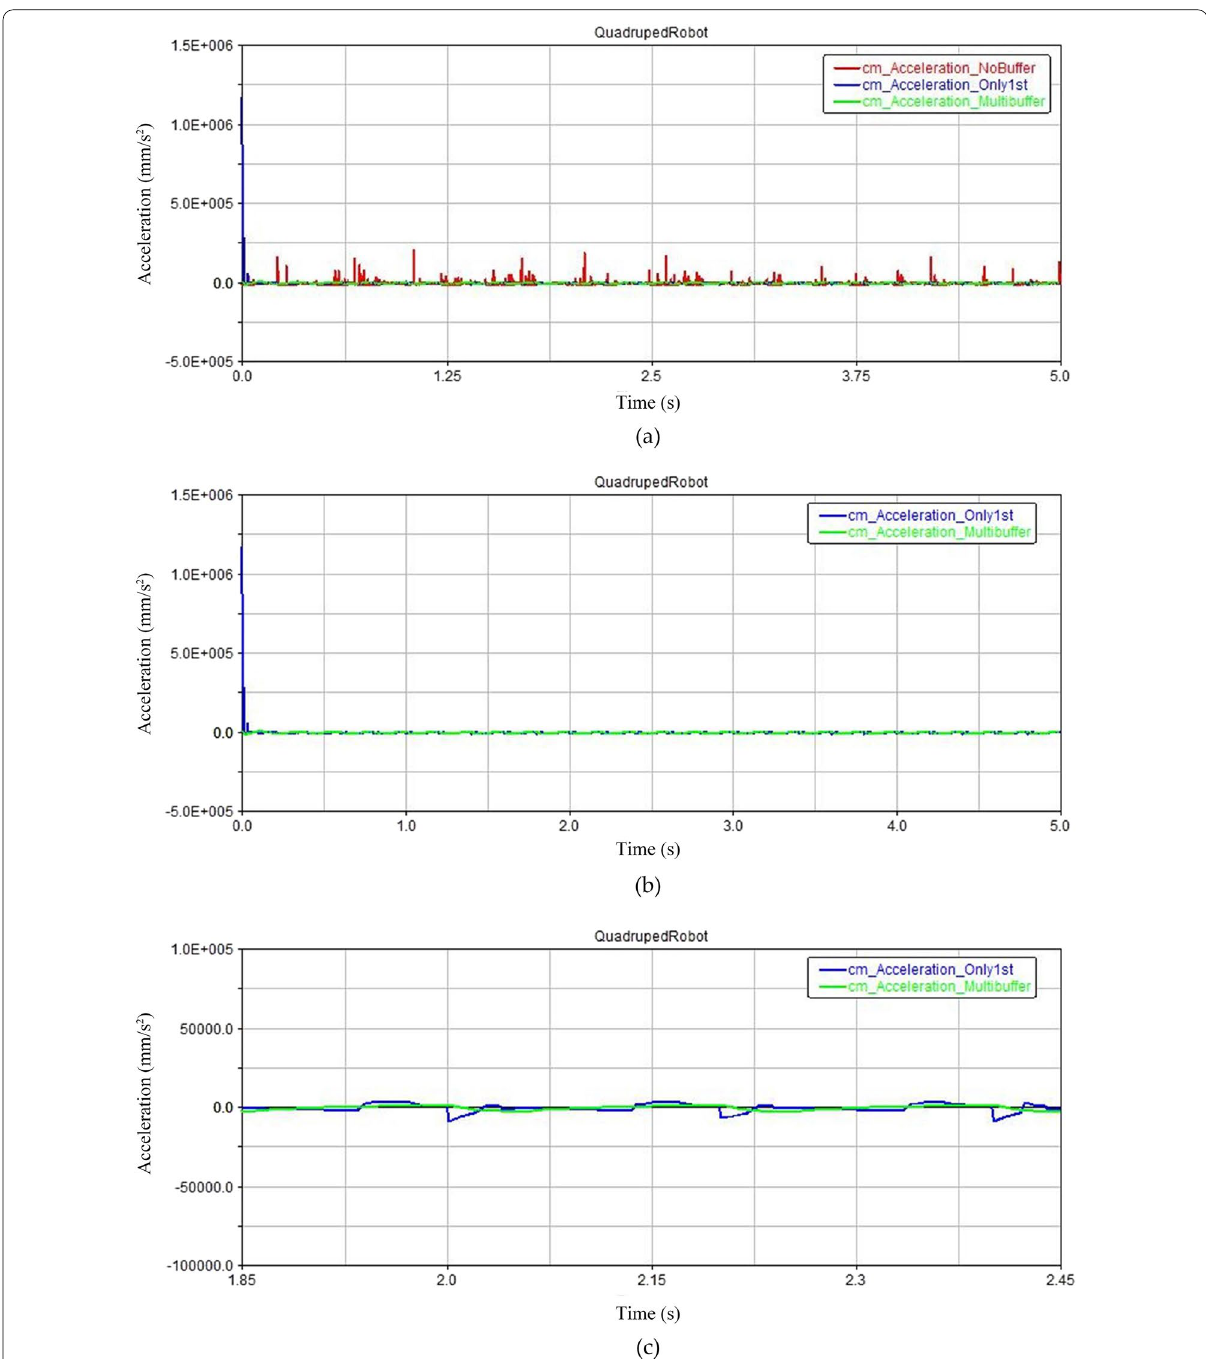
Figure 26 ADAMS simulation results: a acceleration variation of the robot COM in three cases, b acceleration variation comparison between the two latter cases, c walking process curves between 1.85 and 2.45 s for the two latter